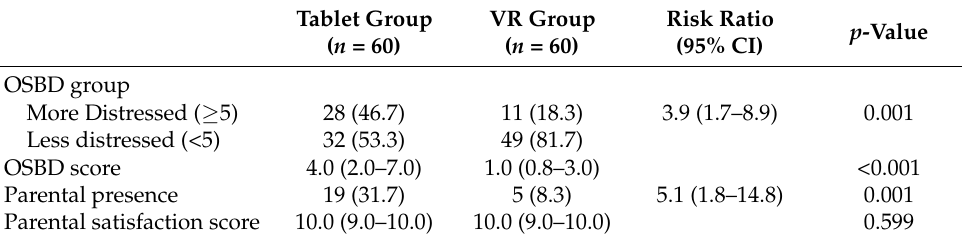
Table 2. Distress of pediatric patients, the need of parental presence and parental satisfaction during chest radiography .